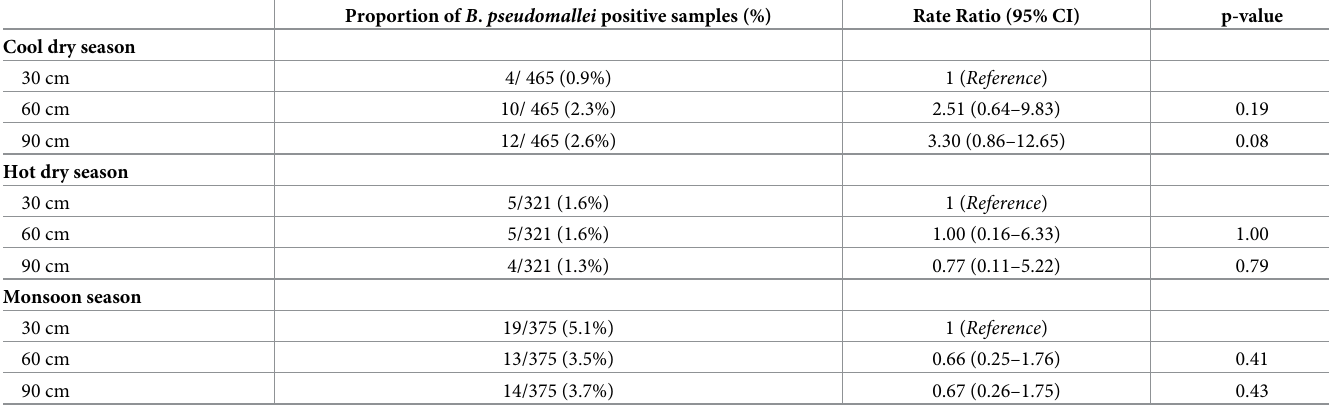
Table 3. Association of soil depth and isolation of B . pseudomallei by season. Proportion of B . pseudomallei positive samples